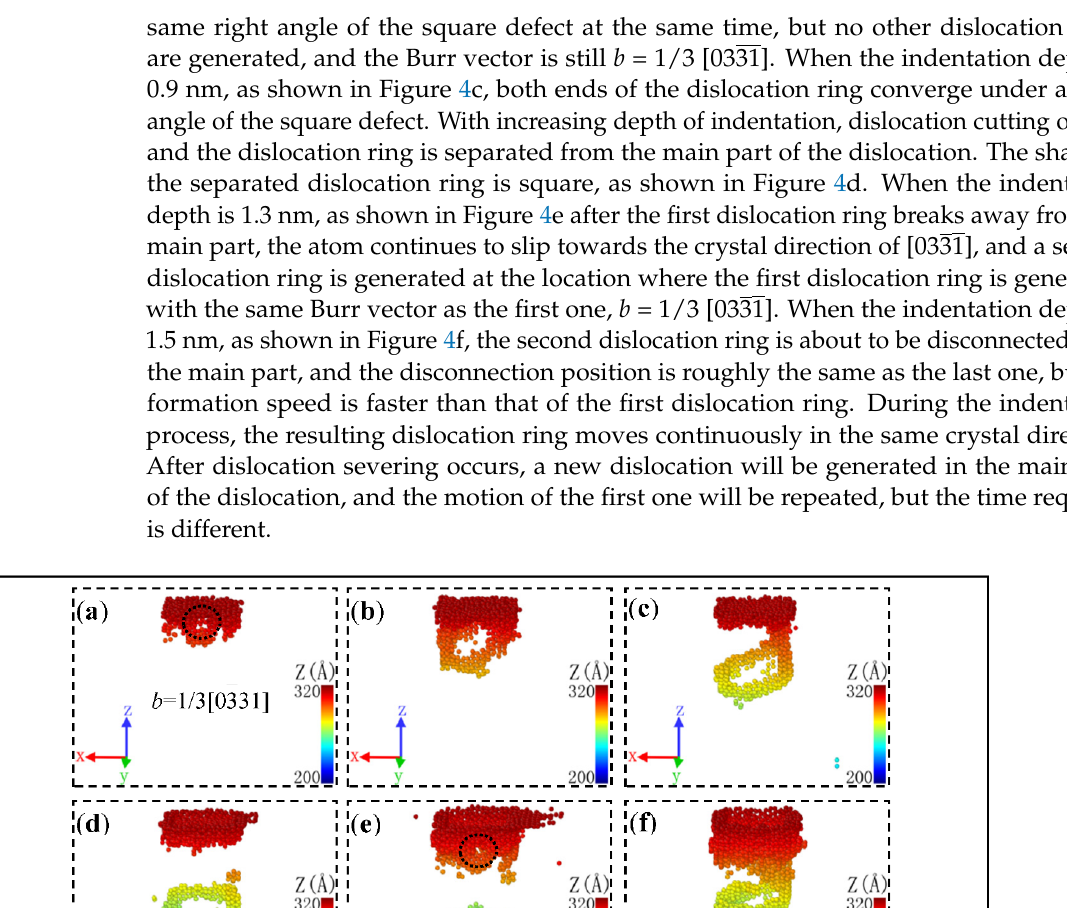
Figure 4. Deformation process of 6H-SiC (211